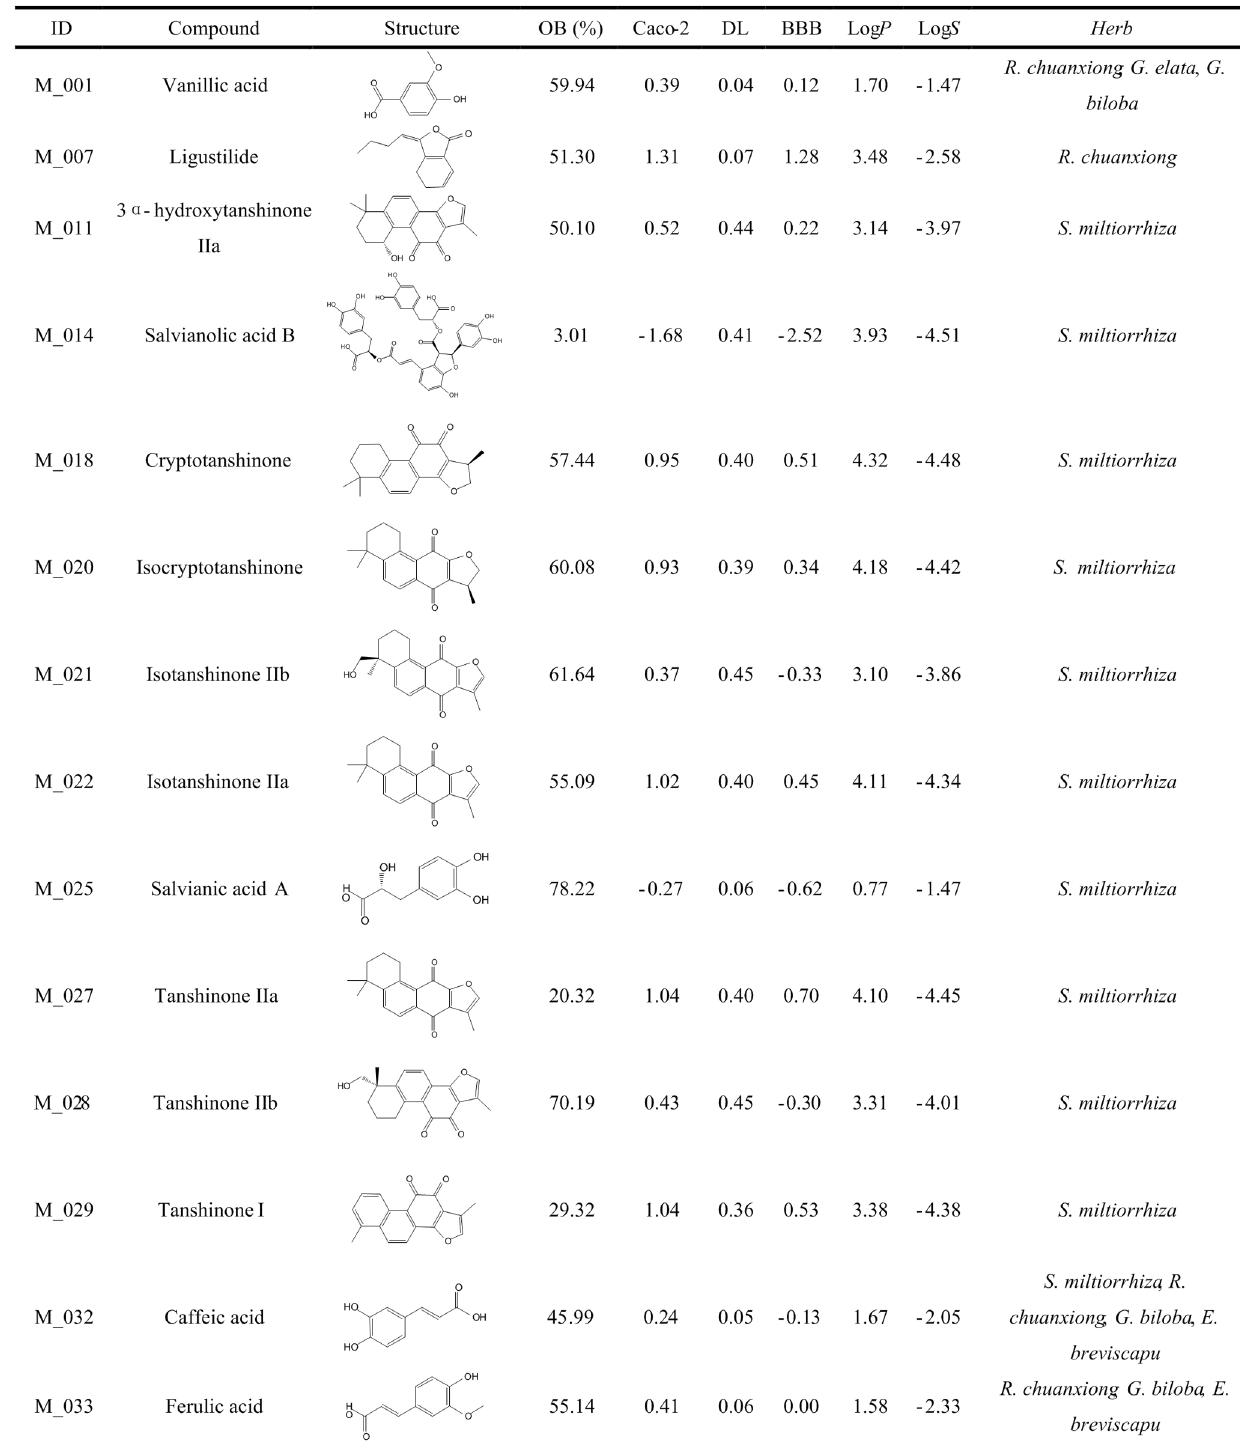
Figure 1. Representative active constituents of anti-stroke herbs and their corresponding ADME parameters (Part 1).